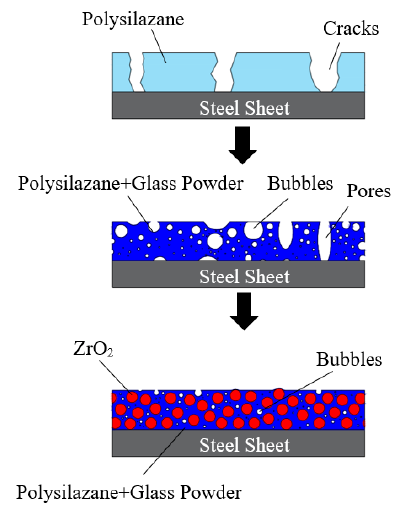
Figure 10. Mechanism of pore inhibition by adding fillers to the coating.